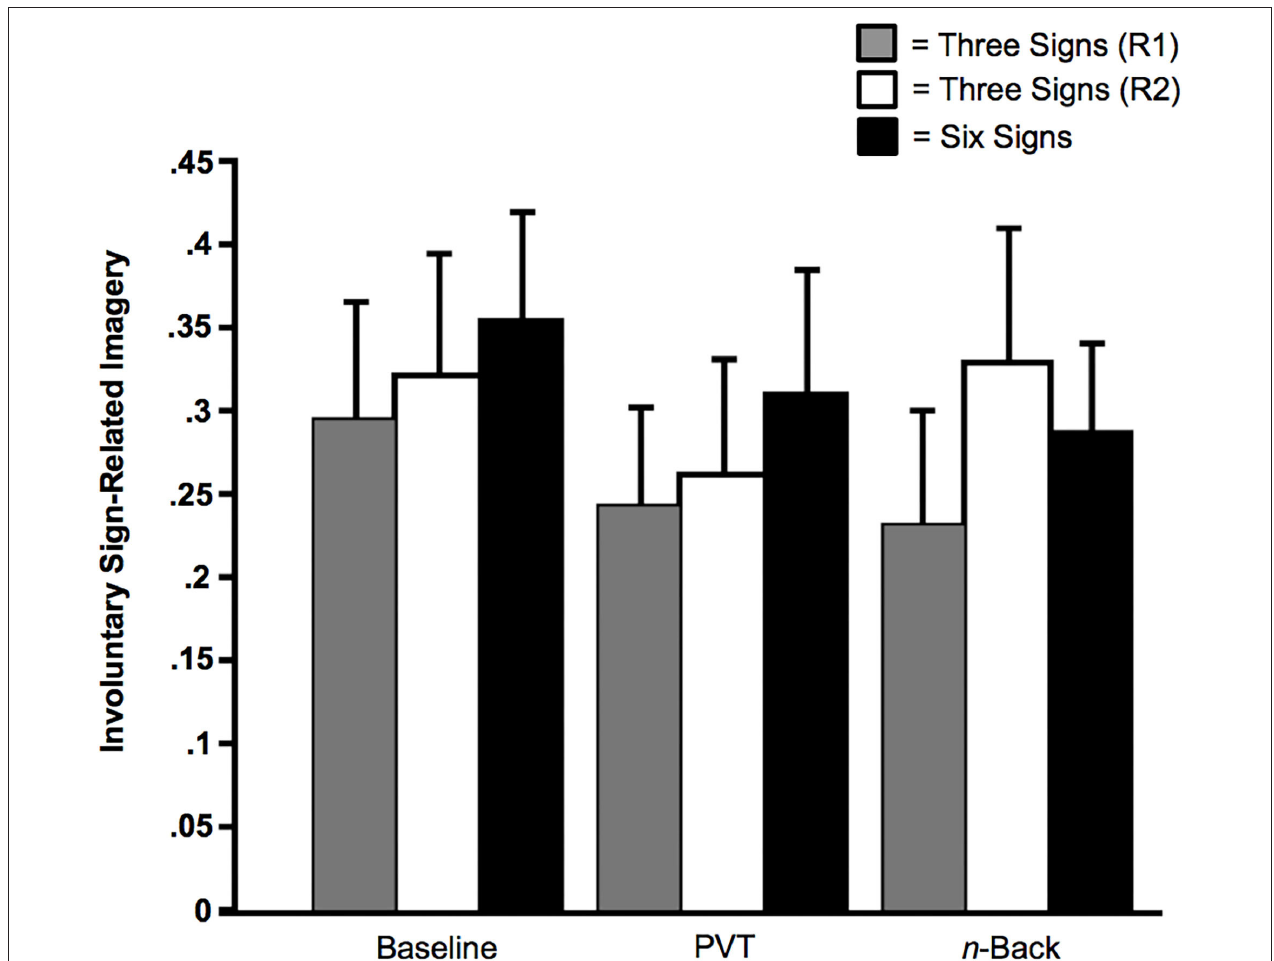
FIGURE 6 | Sign-related involuntary imagery as a function of Memoranda (three signals or six signals) and Multi-Tasking (None [Baseline], Psychomotor Vigilance Task [PVT], or n -back). The solid black bars indicate subjects who received training for all six signs. The gray bars indicate subjects who received training for the three signs of Bike Lane, Speed Bump, and Fire Truck (Regimen [R1]); the unfilled bars indicate subjects who received training for the signs of Crosswalk, Railroad Crossing, and Ambulance (Regimen 2 [R2]). Error bars indicate SE s.